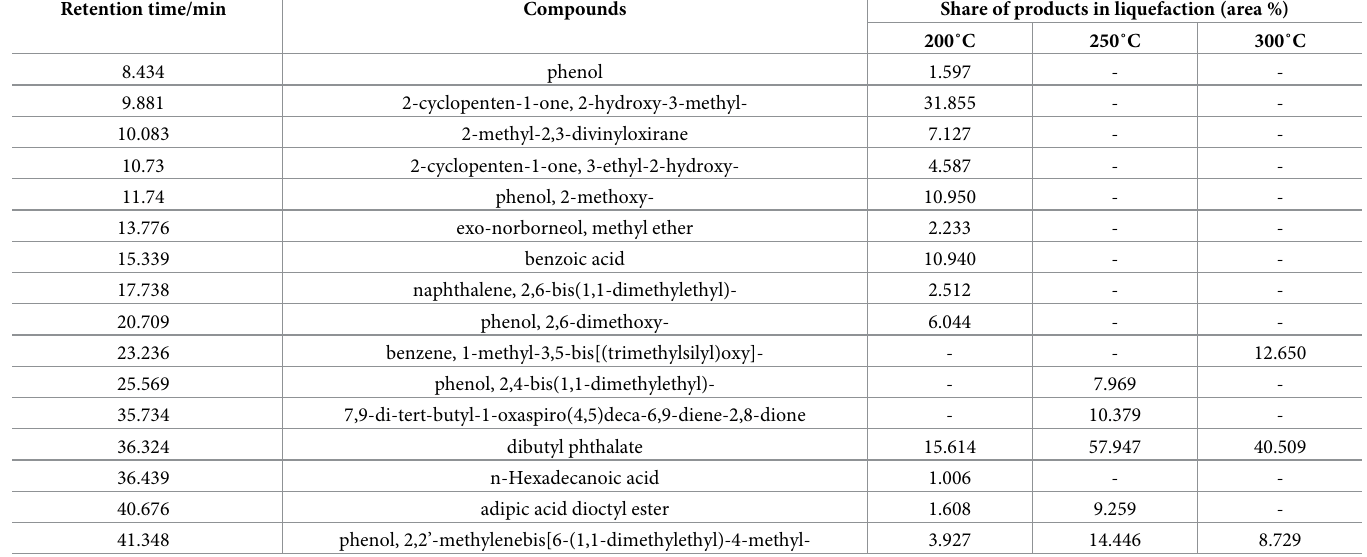
Table 3. Liquid organic products from HTC reactions of cellulose. Retention time/min Compounds Share of products in liquefaction (area